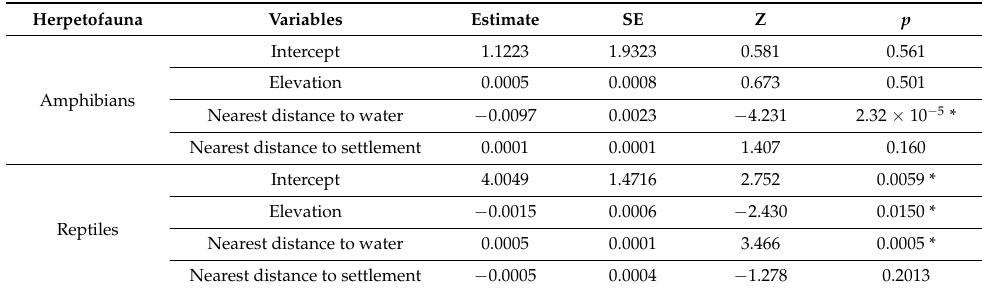
Table 5. Summary of GLM showing the effects of environmental variables on the abundance of herpetofauna in the RWC.